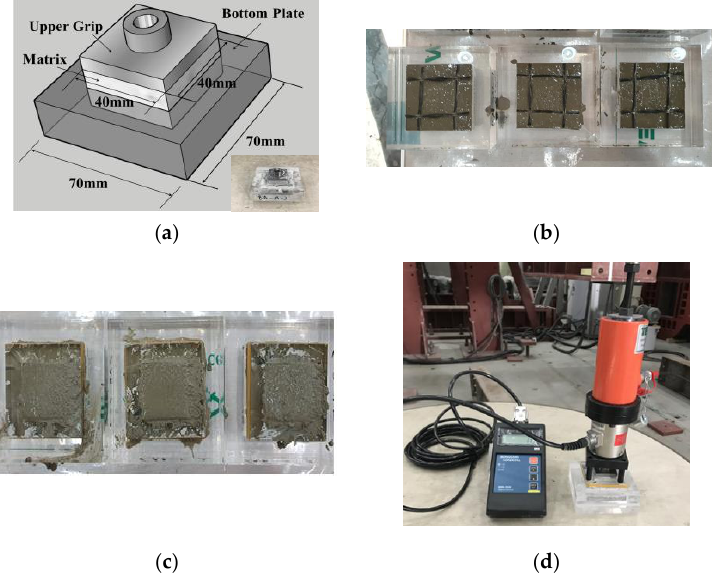
Figure 7. Test of pull-off series: ( a ) pull-off specimen; ( b ) arrangement of textiles; ( c ) pull-off specimens (after casting); ( d ) setup of pull-off specimen.